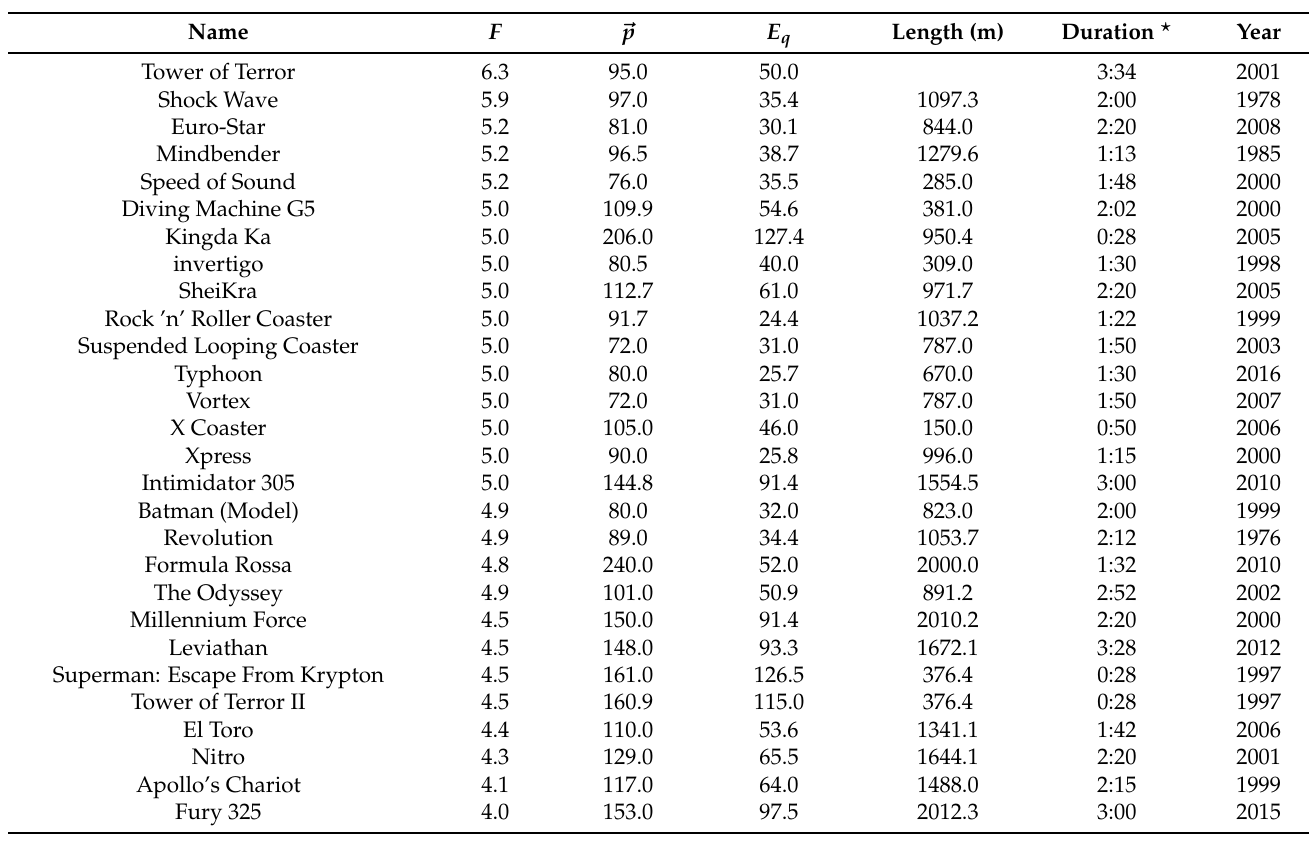
Table 3. The top 11th high G-force roller coaster.